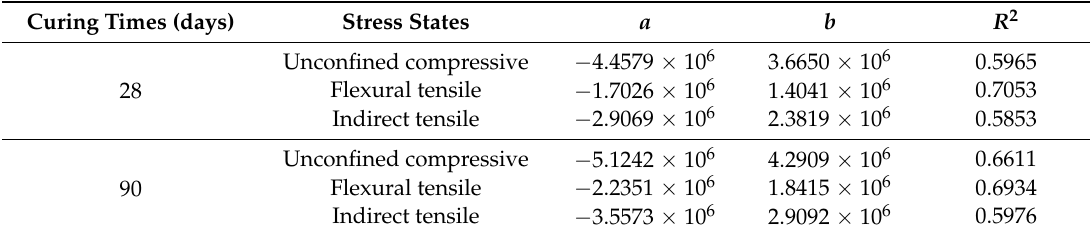
Table 6. Fitting parameters for the fatigue equation with a cement content of 4% under different stress states.